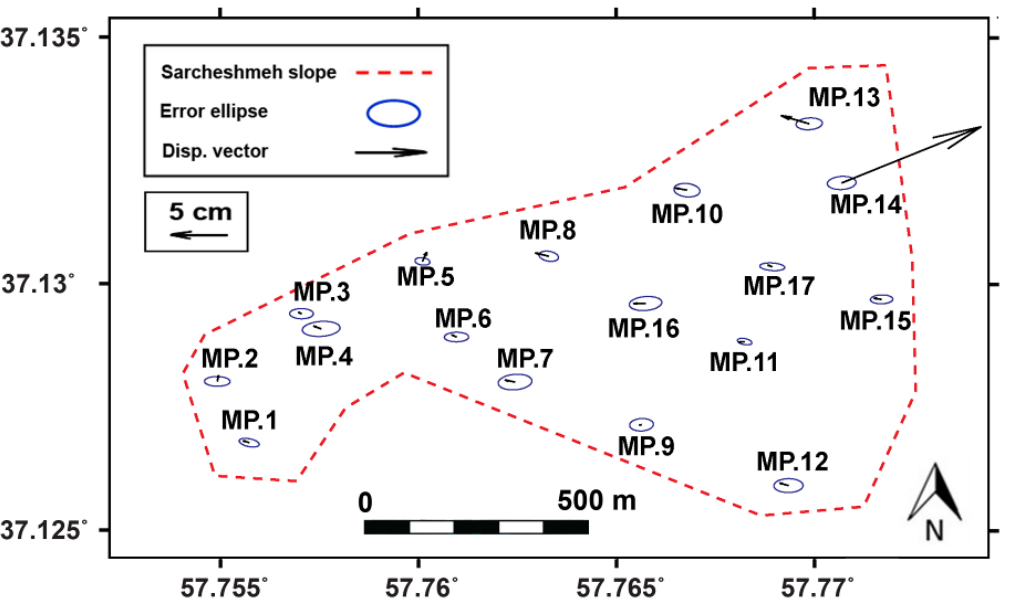
Figure 11. Schematic display of an average horizontal displacement field on the Sarcheshmeh slope spanning the first and the fourth GPS campaign with 95% confidence